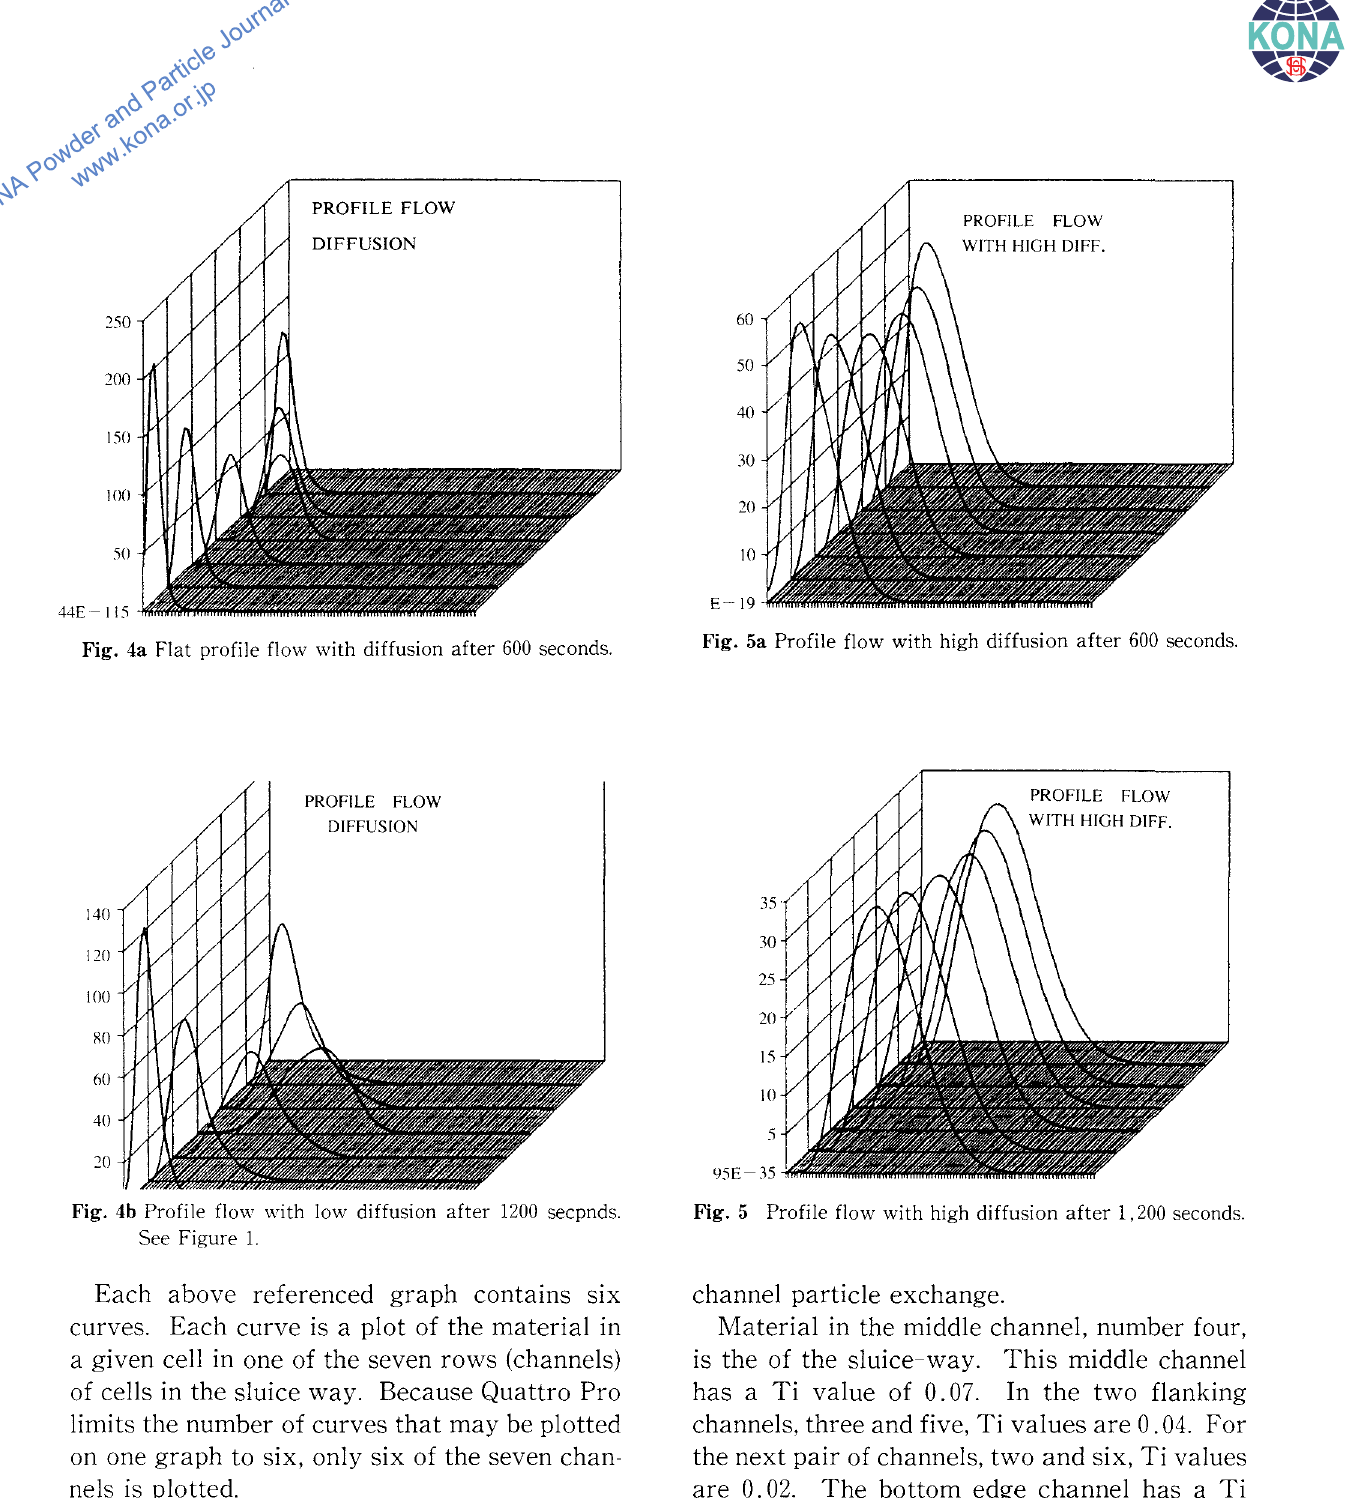
Fig. 4b Profile flow with low diffusion after 1200 secpnds. See Figure 1.